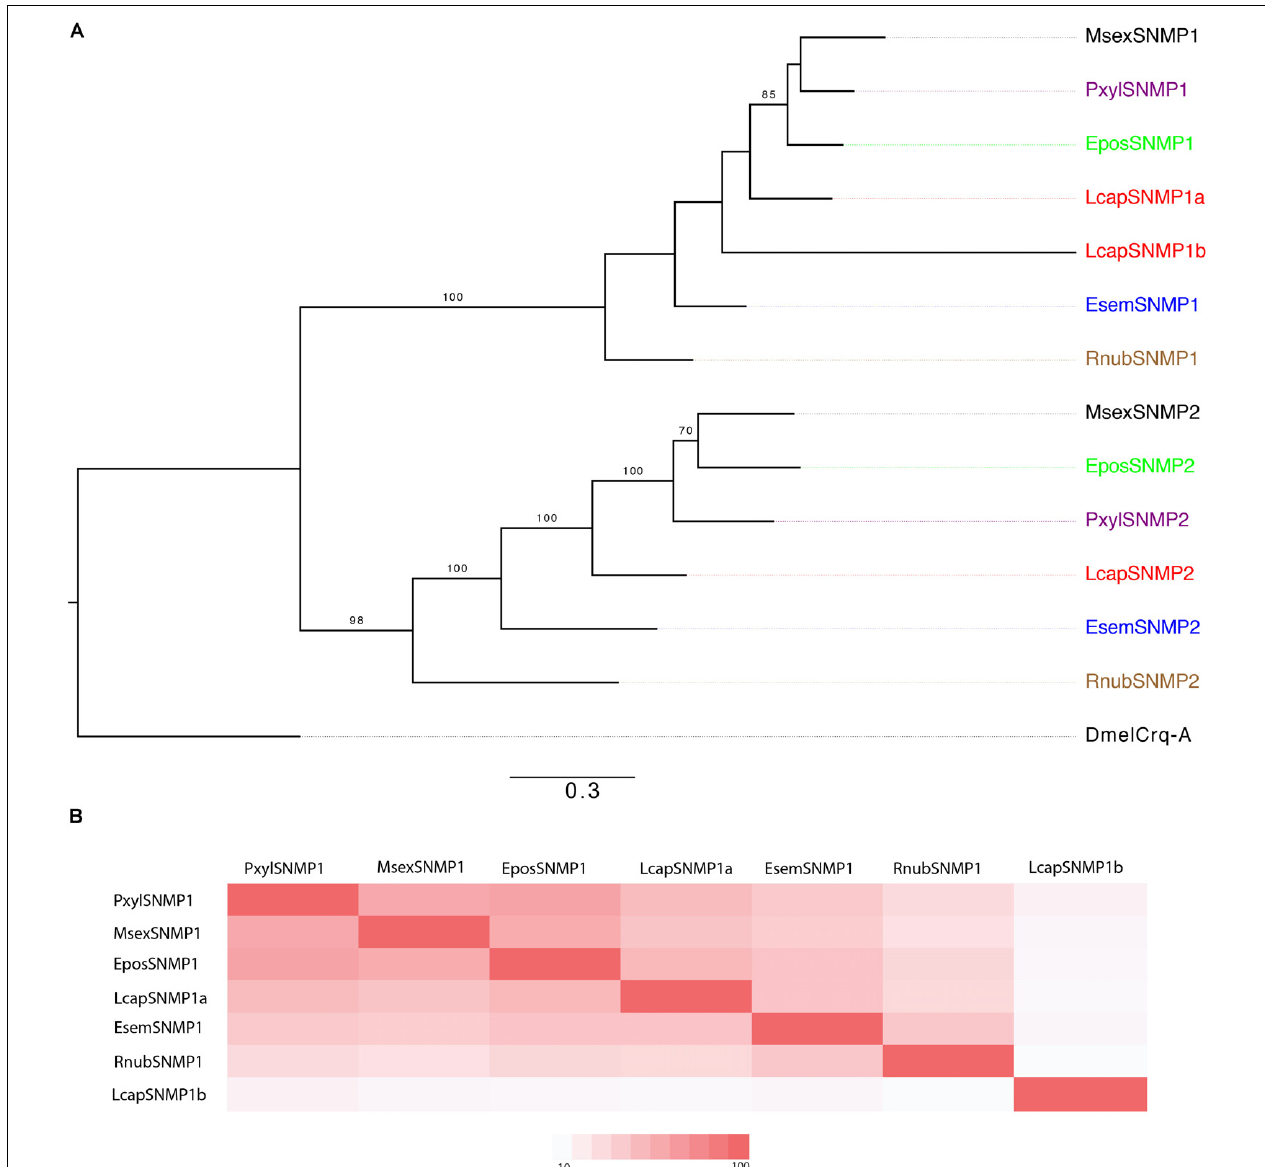
FIGURE 6 | (A) Maximum-likelihood phylogram of sensory neuron membrane proteins (SNMPs), rooted with a non-SNMP member of the CD36 family (Croquemort, Dmelcrq-A). Included are SNMP sequences from R. nubila (brown), L. capitella (red), E. semipurpurella (blue), E. postvittana (green), M. sexta (black), and P. xylostella (purple). Bootstrap support values (500 replicates) are indicated when > 70%. Sources of included SNMP sequences, along with their accession numbers (when applicable), are reported in Supplementary Data Sheet S4 . (B) Comparison of amino acid sequence identity between trichopteran and lepidopteran SNMP1s that are included in the